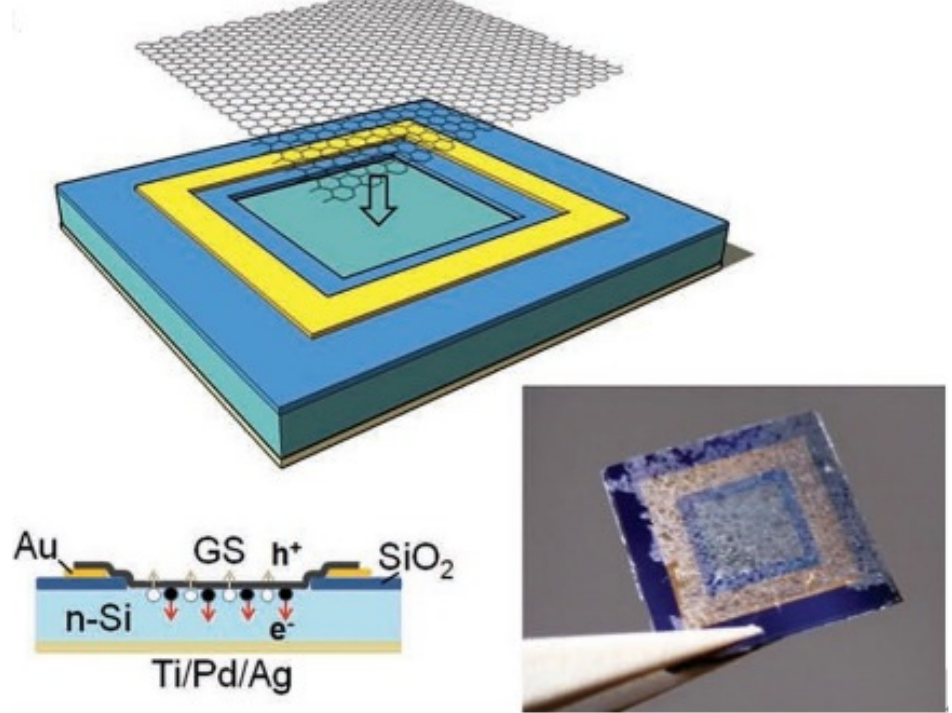
Figure 2. Schematic illustration of the device configuration. (Reproduced with permission from ref. [46]. Copyright 2010 Wiley Publications).